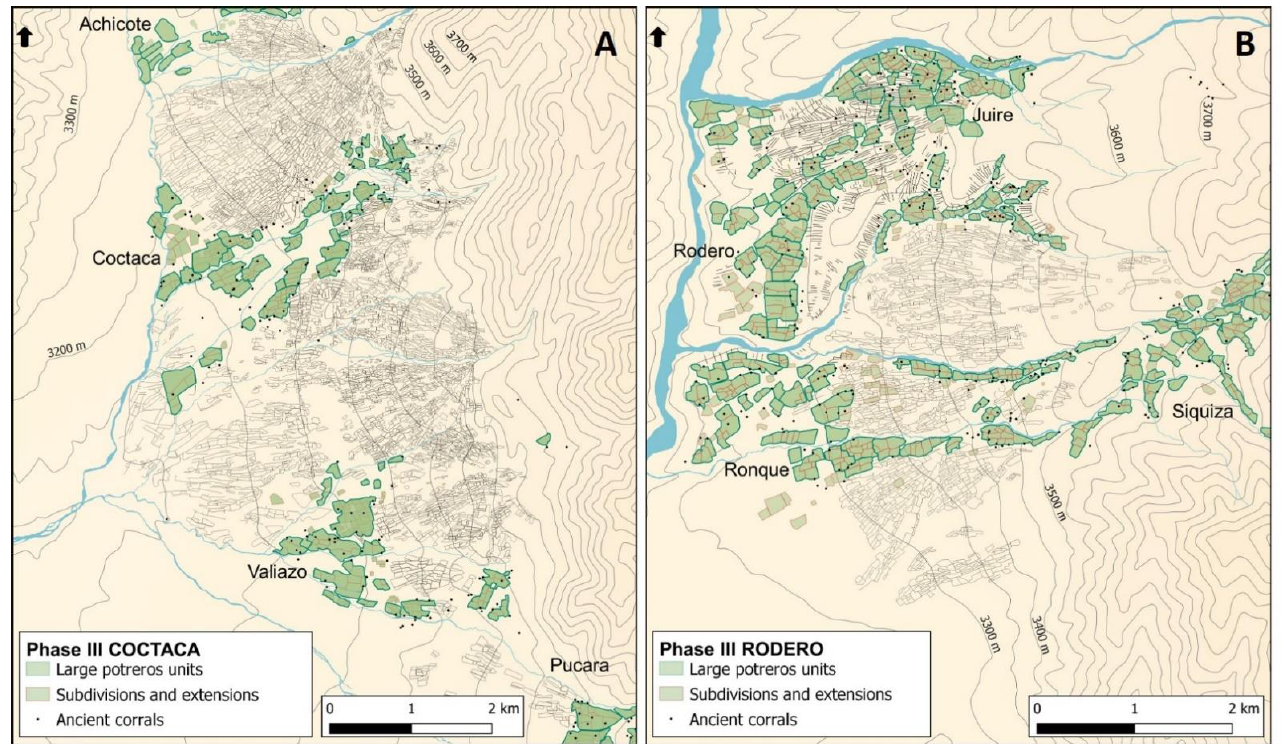
Figure 8. Enclosed-field system at ( A ) Coctaca and ( B ) Rodero.